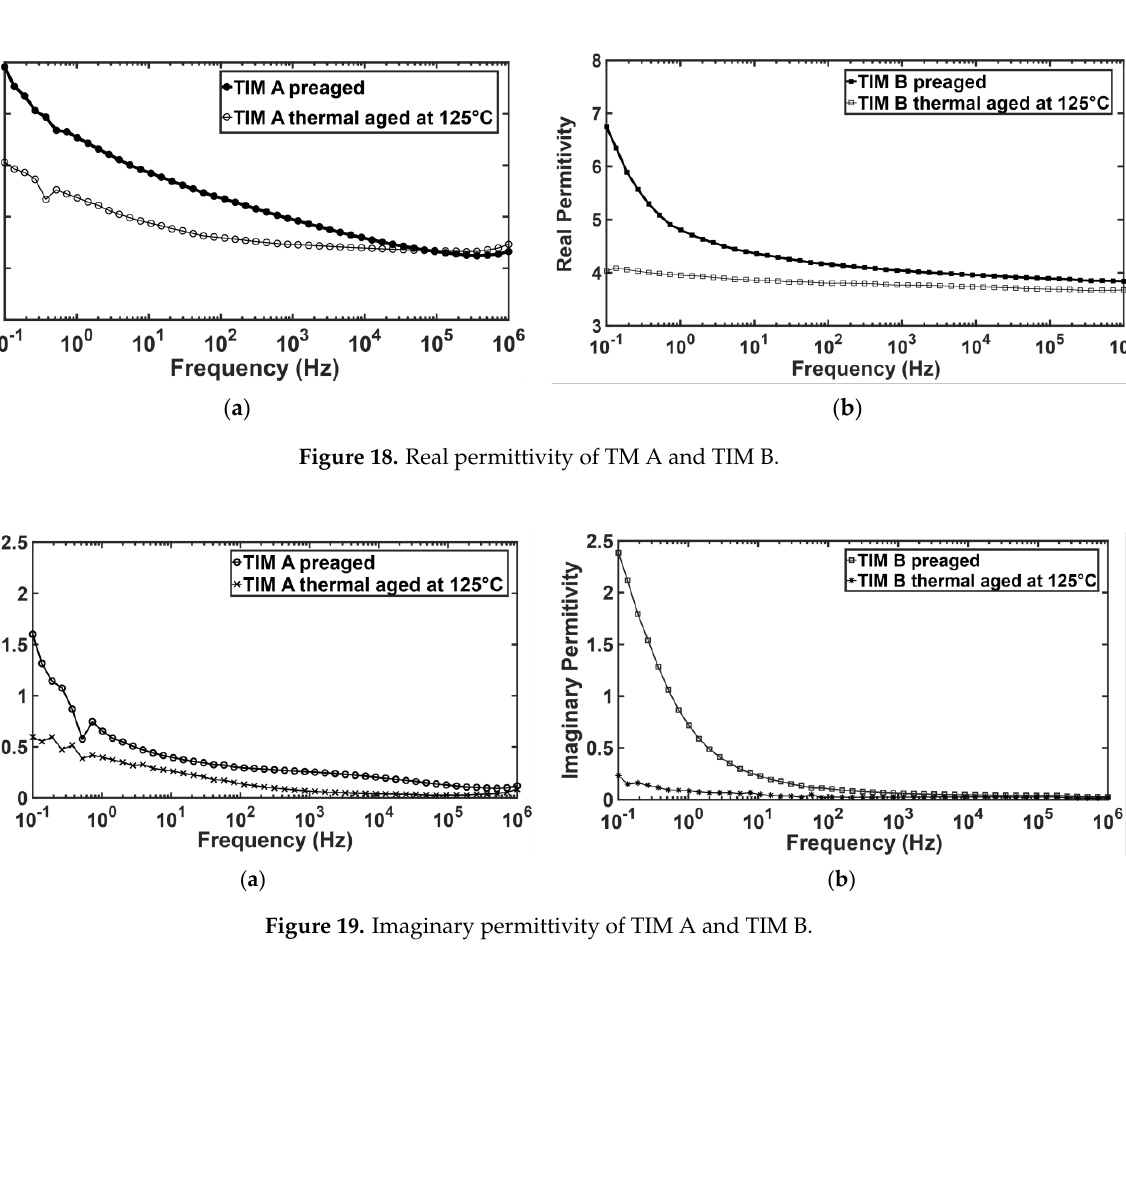
Figure 17. ( a ) FTIR spectra of TIM B preaged, and ( b ) FTIR spectra of TIM B thermal-aged at 125 °C.